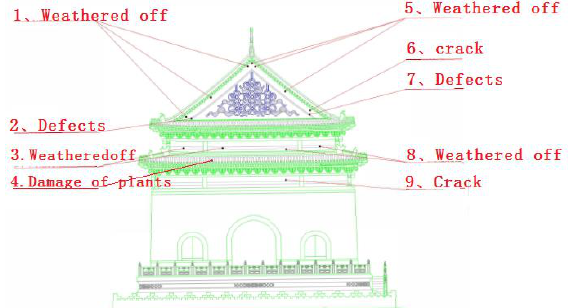
Figure 8. West facade roofing tile map disease of Beijing Bell Tower